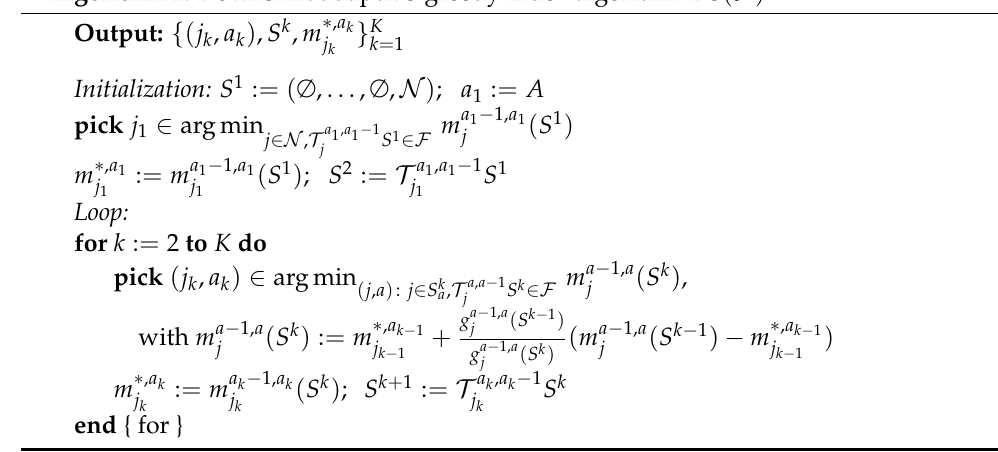
Algorithm 1: Downshift adaptive-greedy index algorithm DS ( F ) .